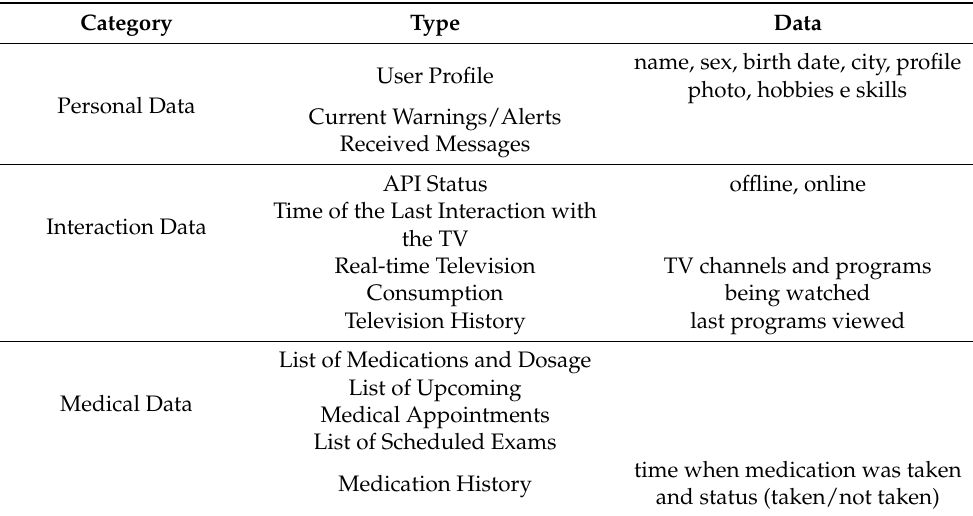
Table 1. Data Associated with the use of SecurHome TV application.